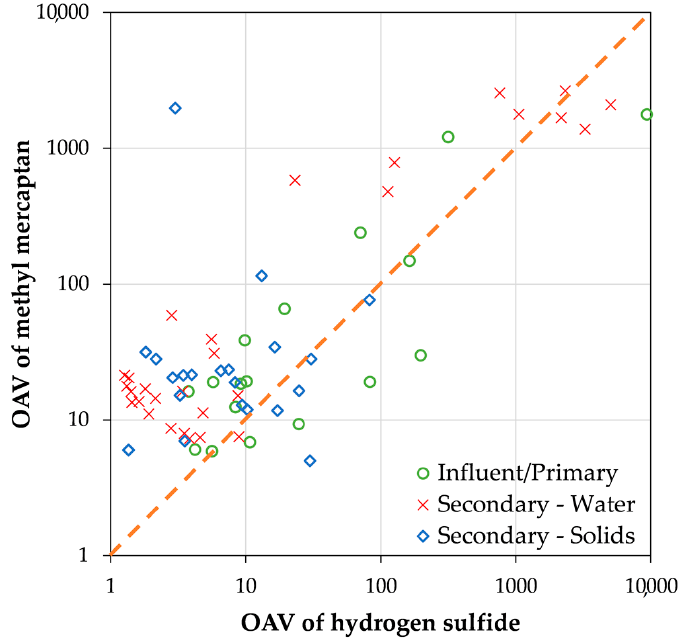
Figure 3. The relationship between the dominant sulfur odorants (hydrogen sulfide and methyl mercaptan) observed at a WWTP using SIFT-MS for the primary (green circles), secondary water (red crosses), and secondary solids (blue diamonds) odor sources. Note the use of odor activity values (OAVs) and logarithmic axes. From Ref. [72]; used with permission of the authors.